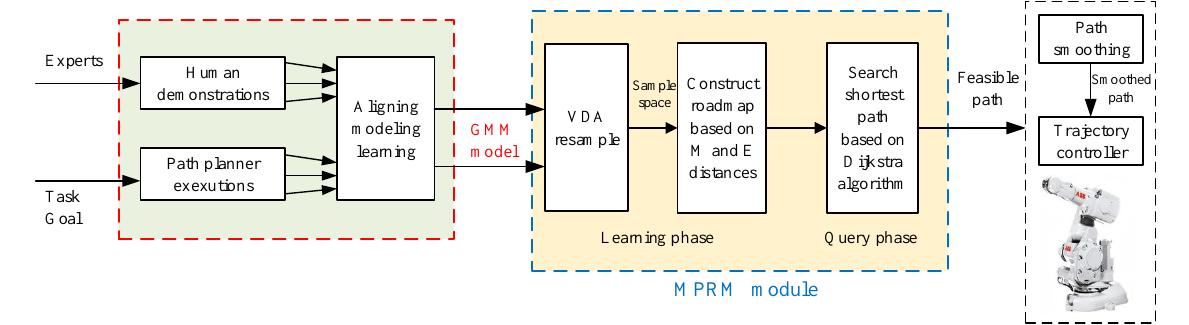
Figure 1. The GMM/GMR-MPRM path planning framework.